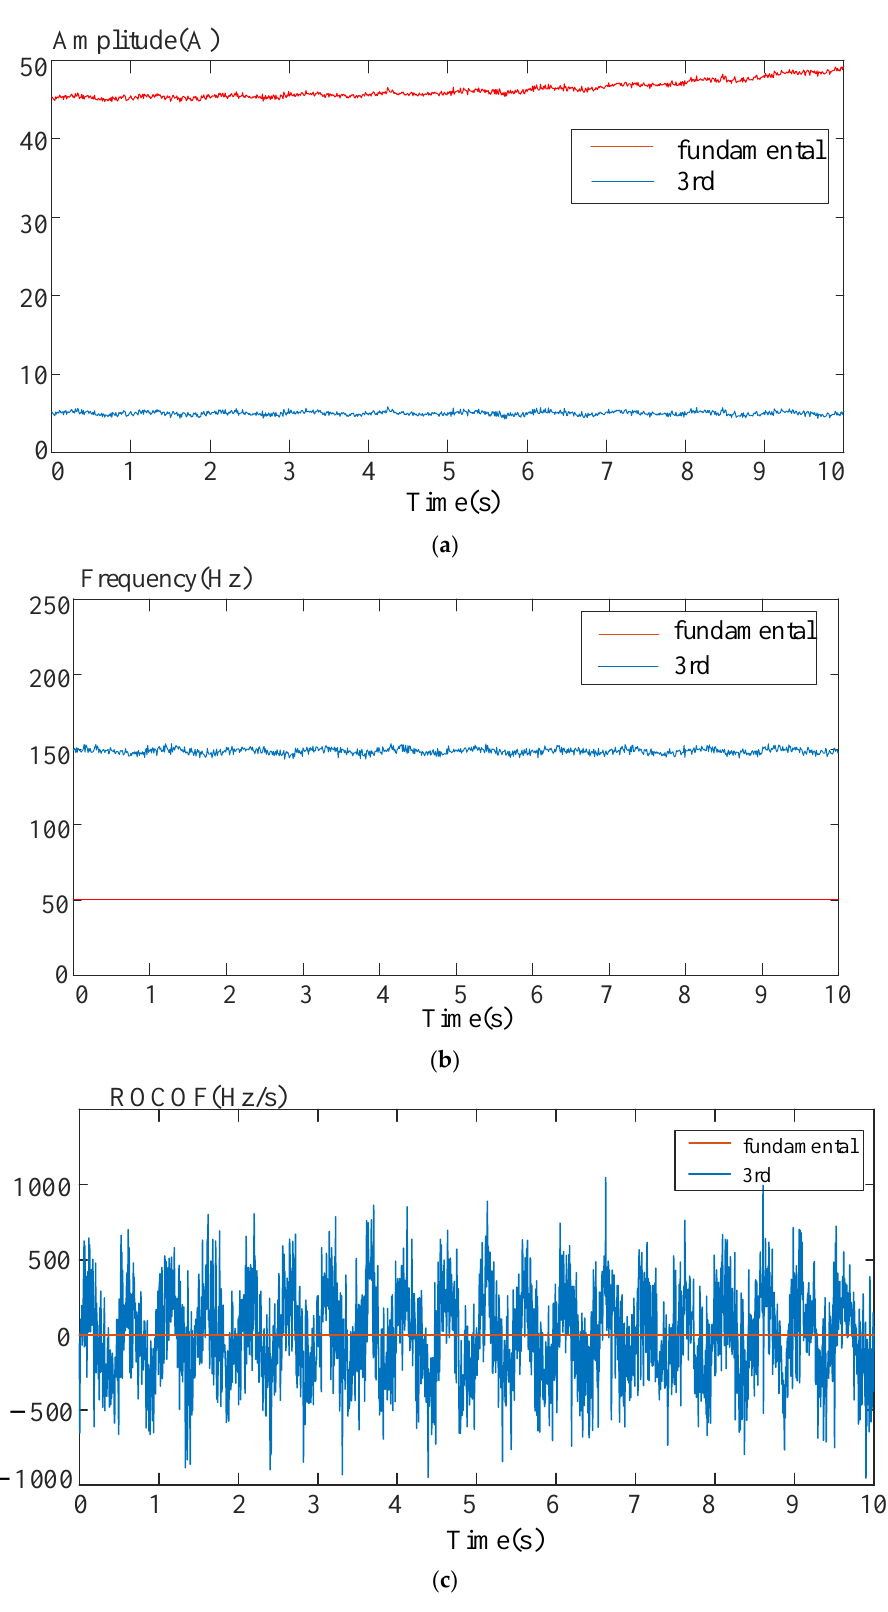
Figure 6. Parameter estimates of the BMP. ( a ) Amplitude estimates. ( b ) Frequency estimates. ( c ) ROCOF estimates.